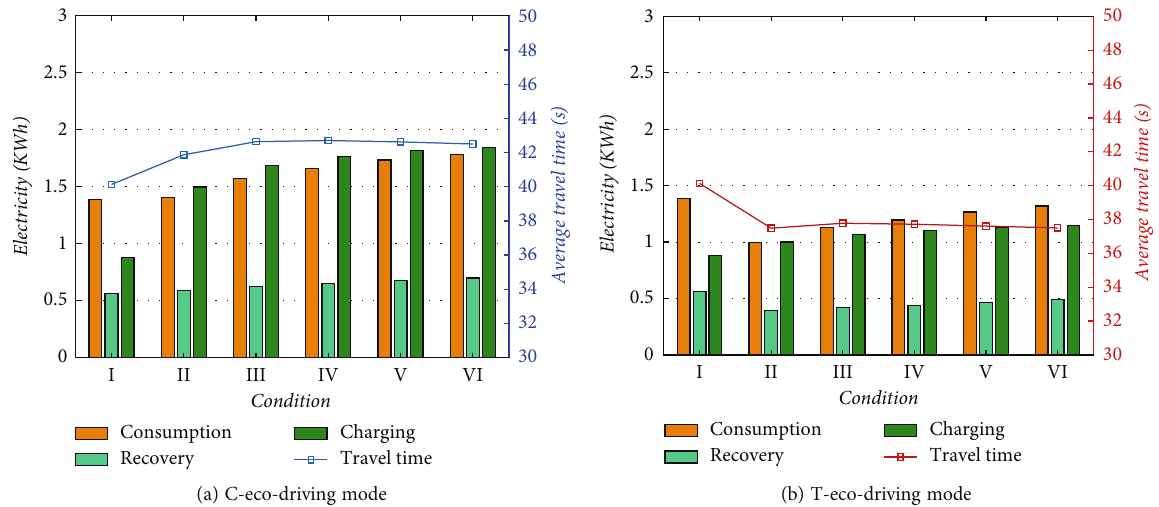
Figure 5: Electricity usage (consumption, recovery, and charging) and average travel time of six conditions (I ~ VI). Table 8: Parameter settings of four numerical examples.